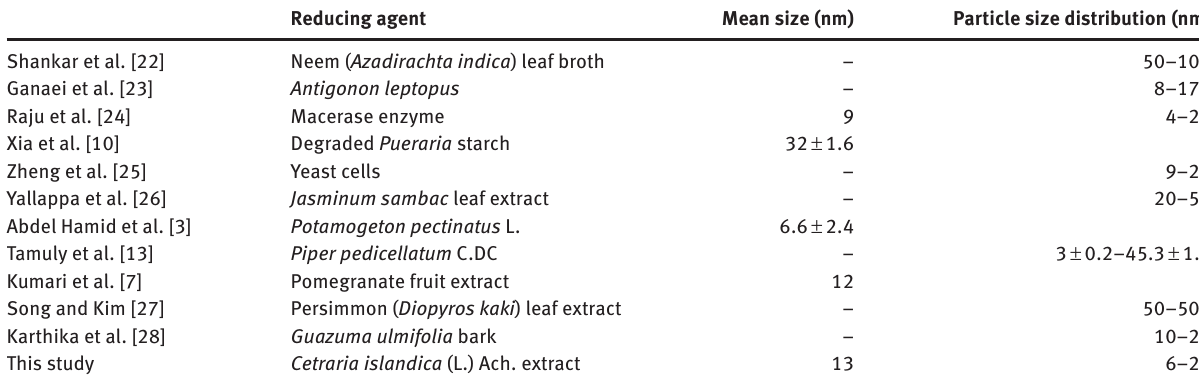
Table 1: Mean particle size and particle size distribution of Ag-Au bimetallic nanoparticles prepared by green reducing agents from the